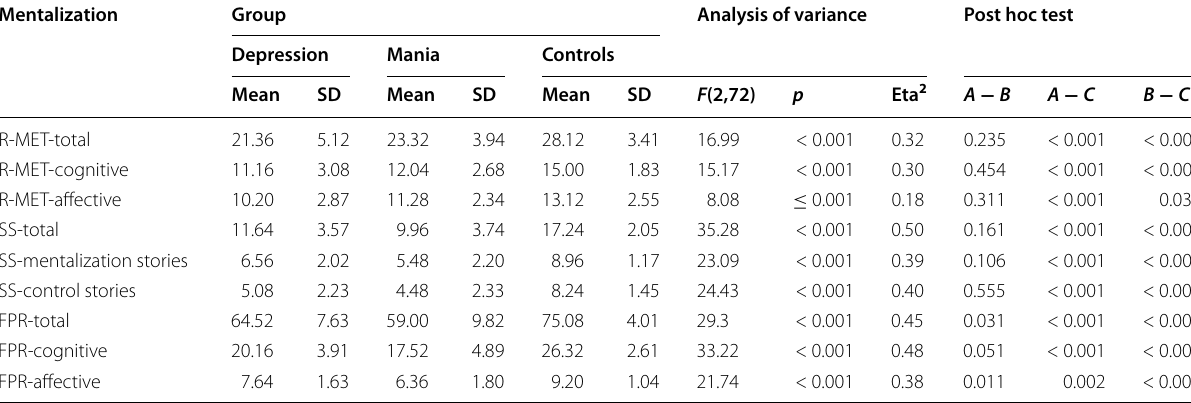
Table 1 The results of mentalization assessed by the Reading the Mind in the Eyes (R-MET), Strange Stories (SS), and Faux Pas Recognition (FPR) tests during depression ( A ), mania ( B ) and in healthy control subjects ( C ) Mentalization